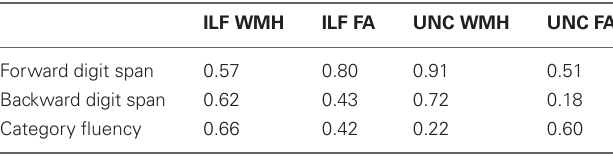
Table 3 | Tract-based multiple regression model p -values for WMH and FA covariates as predictors of control cognitive